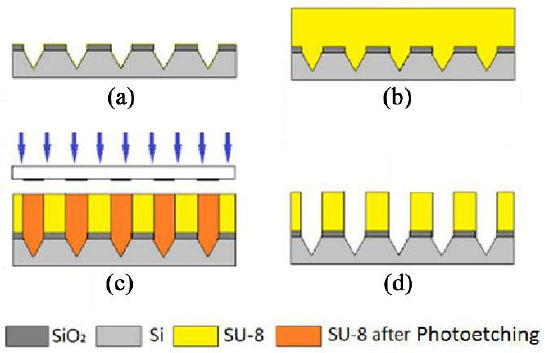
Figure 2. Manufacturing process of MNA tip array. ( a ) Exposure. ( b ) Developing. ( c ) Silica etching. ( d ) Silicon etching.